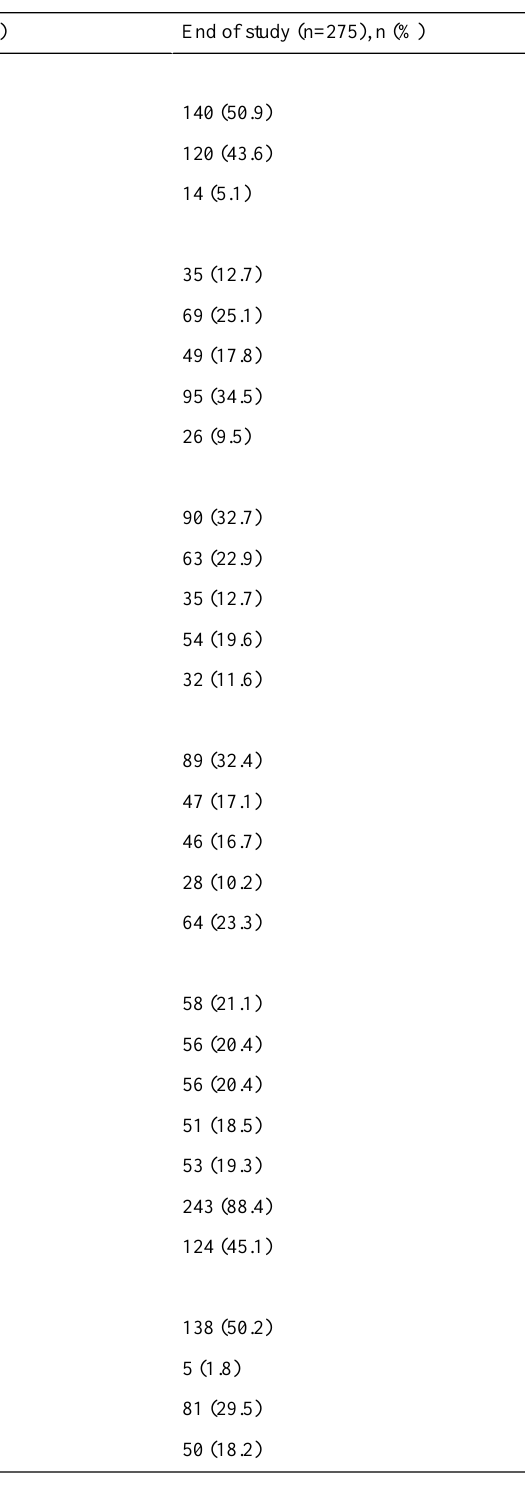
Table 2. Characteristics of study participants at baseline and the end of the